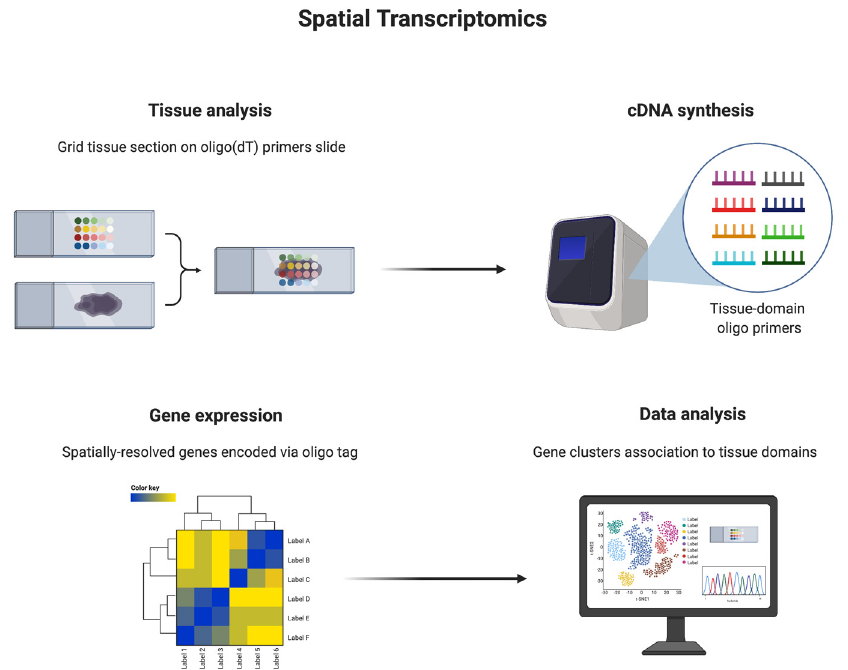
Figure 2. Spatial transcriptomics is a technology used to spatially resolve RNA-seq data, and thereby all mRNAs, in individual tissue sections. This technique allows for gene activity measurements and mapping in tissue samples. Tissue samples are prepared on glass slides and, by means of tissue-domain oligo primers, genes are encoded. Finally, data are analyzed, and gene clusters are associated with tissue domains. Reprinted from Spatial Transcriptomics, by BioRender.com (2021). Re- trieved from https://app.biorender.com/biorender-templates, accessed on 3 September 2021.